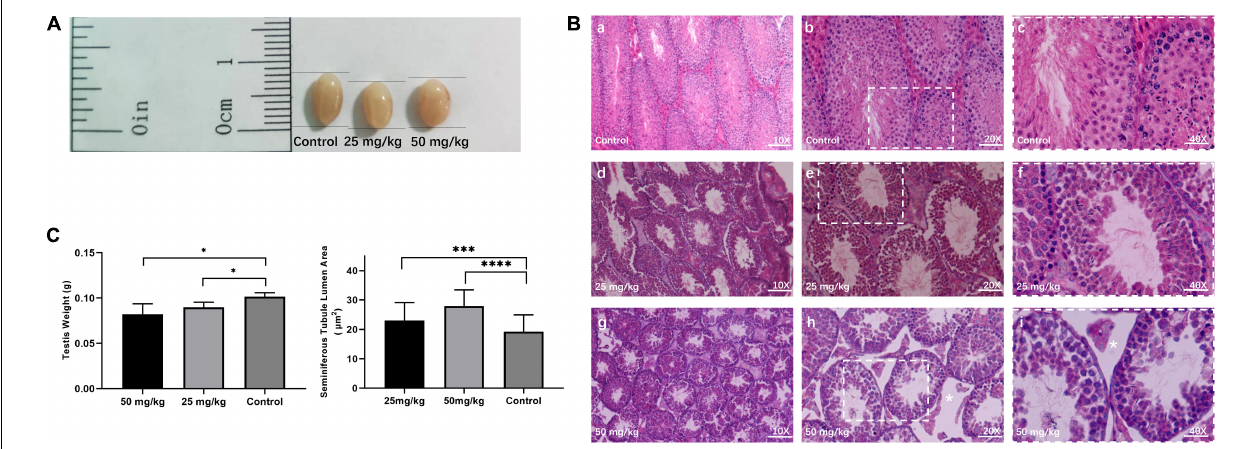
FIGURE 1 | Testicular histomorphology of mice after HU treatment. (A) Representative image of testes from control and mice injected with 25 and 50 mg/kg of HU. (B) The H&E staining of the testis from control and HU-injected mice. Normal mice spermatogenesis present in control testes (a, b, and c, magnification bar = 10 × , 20 × , and 40 × , respectively). Decreased germinal epithelium area was observed in mice injected with either 25 mg/kg (d, e, and f) or 50 mg/kg (g, h, and i) of HU. c, f, and i show that the rectangular area with the white dotted lines in b, e, and h delineates the higher magnification image. As previously described, white stars indicate that loss of fluid in the seminiferous tubules due to decreased testosterone in mice injected with 50 mg/kg of HU (Jones et al., 2009). Bars a, d, and g: 100 µ m; d, e, and h: 50 µ m; and c, f, and i: 25 µ m. (C) Mean testis weight and area of seminiferous tubule lumen from controls and mice injected with 25 and 50 mg/kg of HU. Five mice were analyzed for each group, and the data as mean ± SD were compared between groups using the Mann–Whitney U -test. Asterisks denote significance ( ∗∗∗ p < 0.0005, ∗∗∗∗ p < 0.0001 and ∗ p <